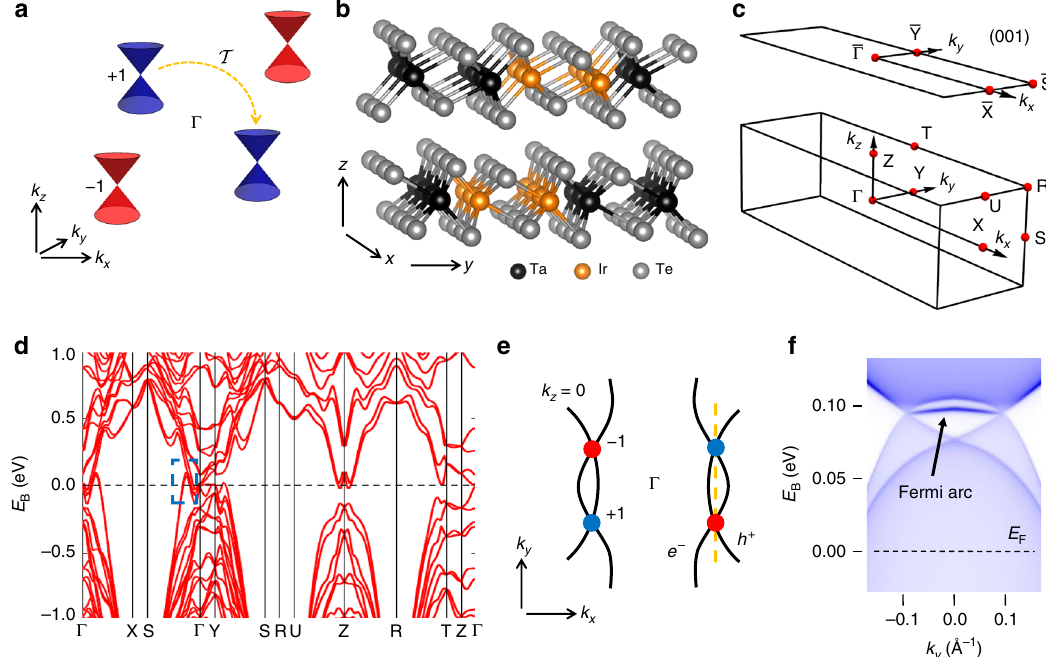
Fig. 1 Constraints on Weyl points in T symmetric systems. a Illustration of the minimal number of Weyl points in a T invariant Weyl semimetal. The blue and red circles and cones represent Weyl points and Weyl cones with ± 1 chiral charge at generic k -points. In a T invariant Weyl semimetal, the minimal number of Weyl points is four because T symmetry sends a Weyl point of a given chiral charge at k to a Weyl point of the same chiral charge at − k ( orange arrow ). To preserve net zero chiral charge, four Weyl points are needed. b The crystal structure of TaIrTe 4 is layered, in space group 31, which breaks inversion symmetry. c The bulk Brillouin zone ( BZ ) and (001) surface BZ of TaIrTe 4 with high-symmetry points marked in red . d The electronic band structure of TaIrTe 4 along high-symmetry lines. There is a band crossing in the region near Γ , with Weyl points off Γ − S ( blue box ). e Cartoon illustration of the constant-energy contour at E B = E W and k z = 0, with bulk electron and hole pockets which intersect to form Weyl points. A detailed calculation shows that there are in total four Type II Weyl points ( blue and red circles ) 27 . f Energy-dispersion calculation along a pair of Weyl points in the k y direction, marked by the orange line in e . The Weyl points and Fermi arcs live at ~0.1 eV above E F , requiring the use of pump-probe ARPES to directly access the